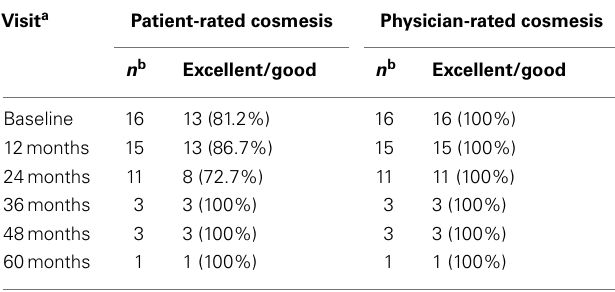
Table 3 | Cosmesis at specific time points